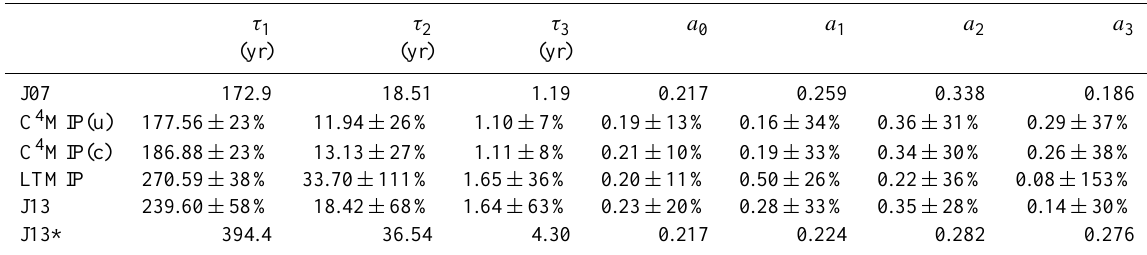
Table 3. Estimates of the parameters in IRF CO : J07 is the IRF CO used in Forster et al. (2007), and C 4 MIP(u), C 4 MIP(c), and LTMIP 2 2 are the IRF CO derived using the corresponding data sets. C 4 MIP(c) represents an experiment with a temperature feedback, and C 4 MIP(u) 2 without. J13* refers to the coefficients as derived and published in Joos et al. (2013). In all the IRF CO is τ 0 = ∞ . The median, and 5- and 2 95-percentile values are